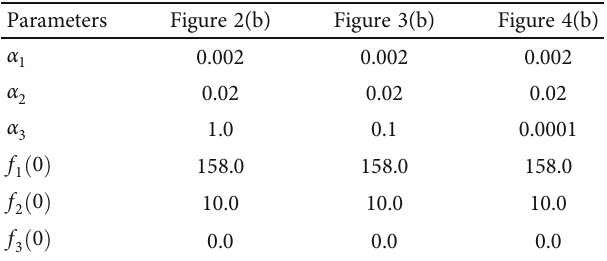
Table 2: The values of initial parameters conditions of the model (1) in France.